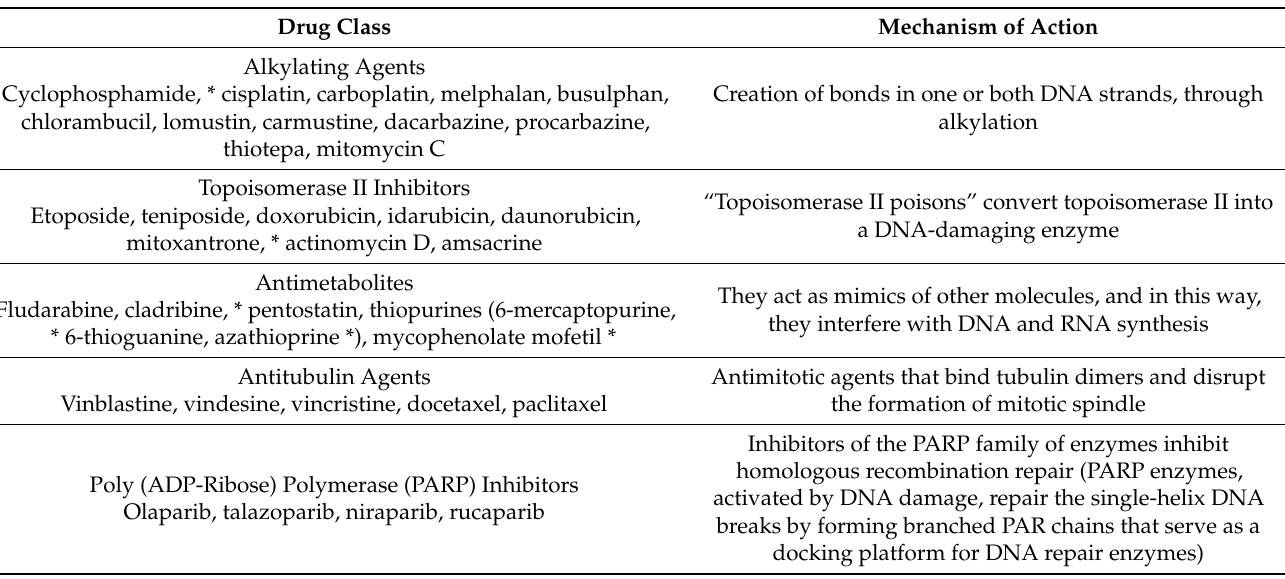
Table 1. Chemotherapeutic agents implicated in